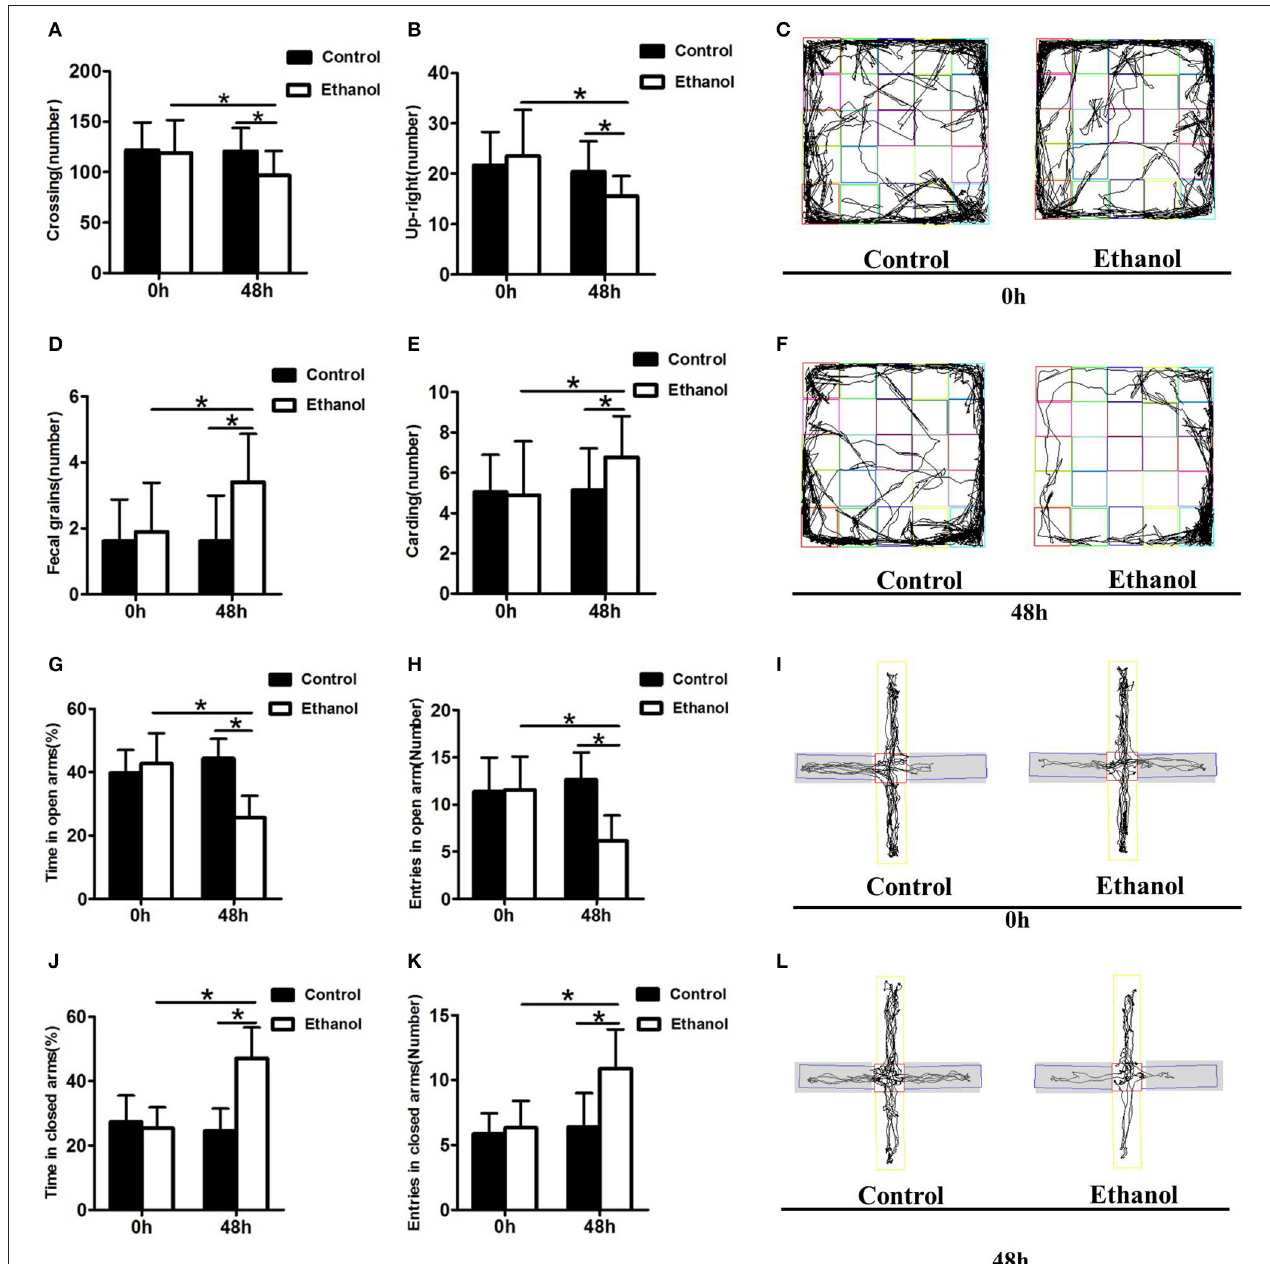
FIGURE 3 | Effect of ethanol withdrawal on the anxiety behaviors. (A) The number of crossings in the OFT. (B) The number of up-right in the OFT. (D) The number of fecal grains in the OFT. (E) The number of carding in the OFT. (C,F) Representative video tracking images during the last 5 min in the OFT. (J,G) Time spent in closed arms and open arms in the EPM. (K,H) Number of entries into closed arms and open arms in the EPM. (I,L) Representative video tracking images during the last 5min in the EPM. 0 h: Before ethanol withdrawal period. 48 h: After ethanol withdrawal period. Data are mean ± standard error. * P < 0.05 was significant.